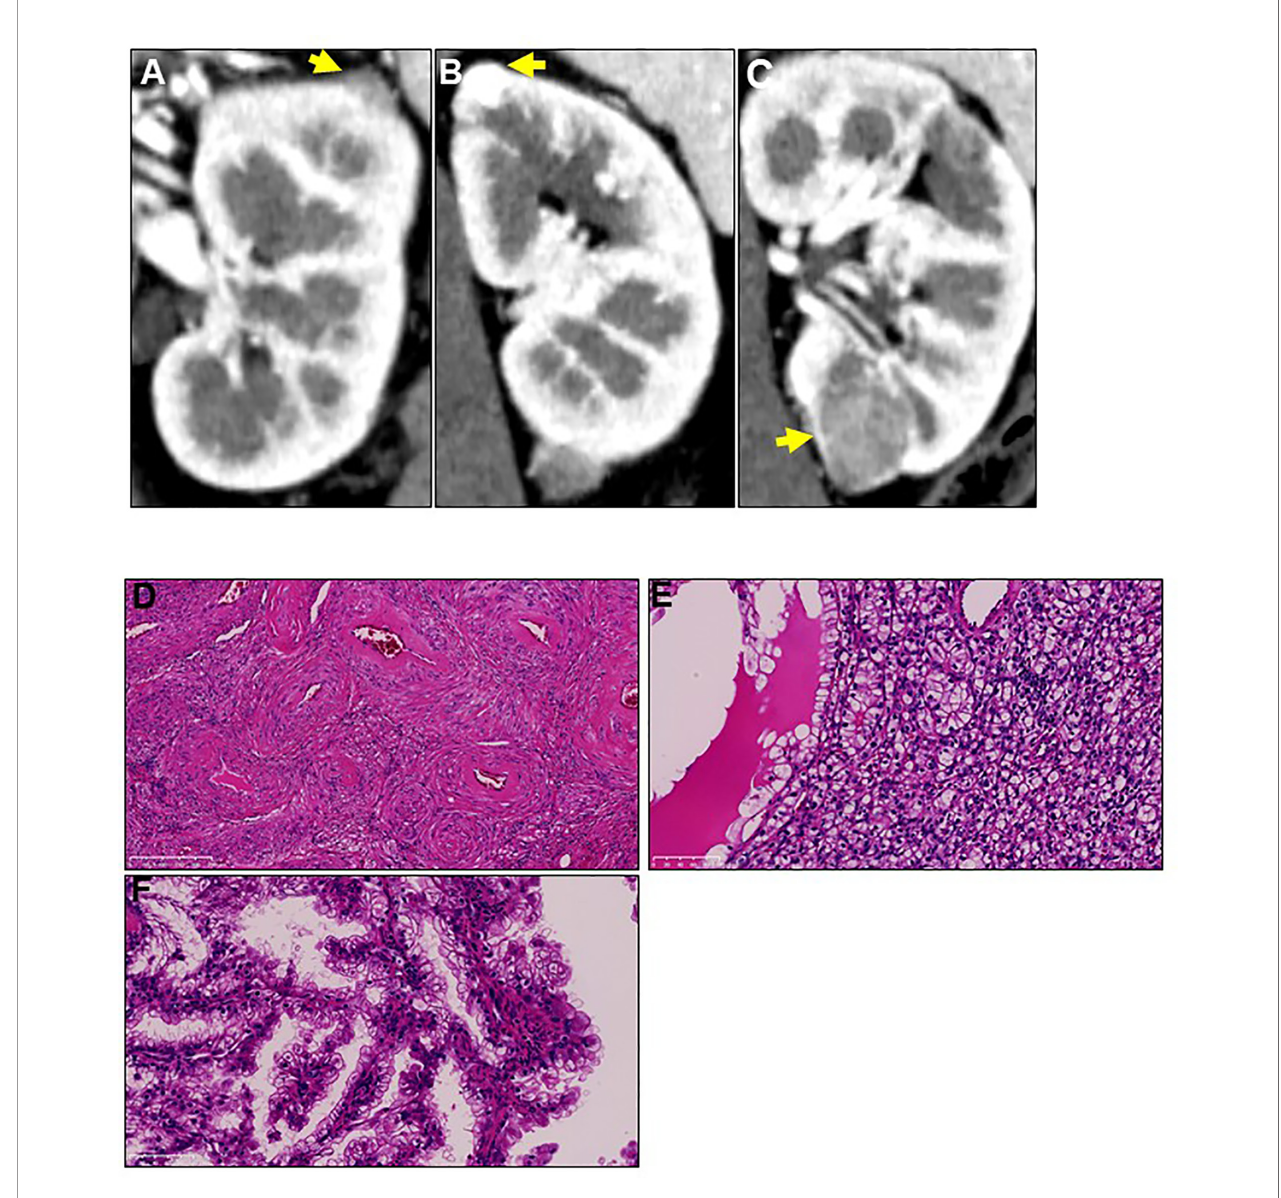
FIGURE 1 | Three different tumors located in the patient ’ s left kidney at fi rst recurrence. Two years after radical right-kidney nephrectomy, the patient was diagnosed with three different tumors (A-C) in her left kidney on computed tomography examination. Yellow arrows show the three tumors. The patient underwent left-kidney partial nephrectomy for all tumors, and immunohistochemical analysis showed that their histopathological types were (D) angiomyolipoma, (E) clear cell renal cell carcinoma, and (F) papillary renal cell carcinoma. Magni fi cation: 200× for hematoxylin and eosin